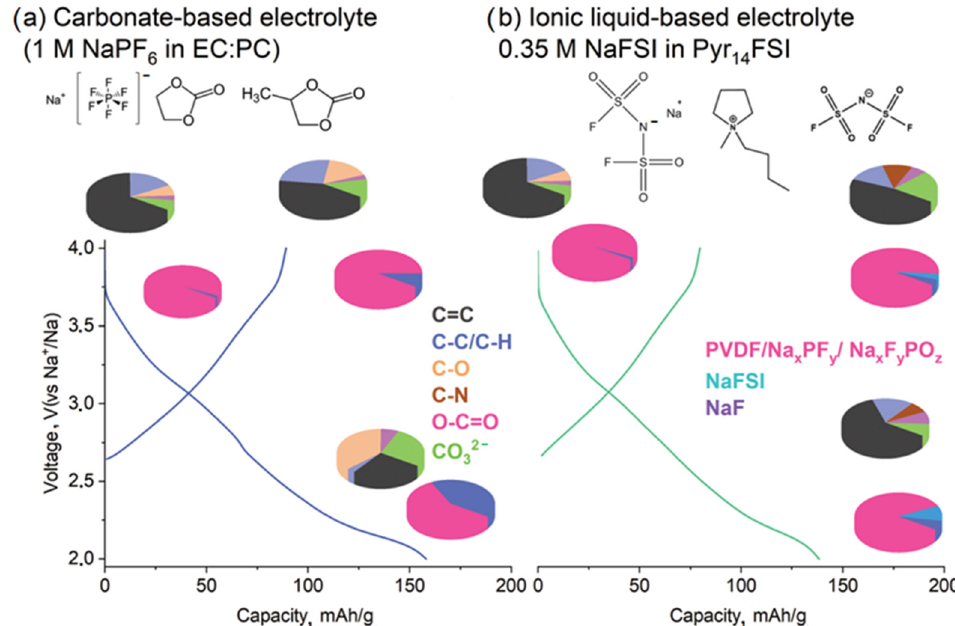
Figure 6. Voltage profile of the 1st cycle and the concentration of the SEI species obtained by fitting C 1s and F 1s photoelectron lines of hard carbon negative electrode tested in ( a ) carbonate ester-based (1 m NaPF 6 in EC:PC) and ( b ) ionic-liquid (0.35 m Na[FSI] in [Pyr14][FSI]) electrolyte. (Reprinted with permission from [67]. Copyright 2022, Wiley Online Library, Open Access).